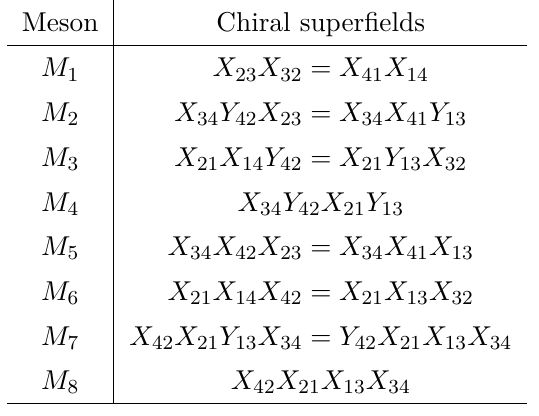
Table 2 . Generators of H 4 in terms of fields in phase